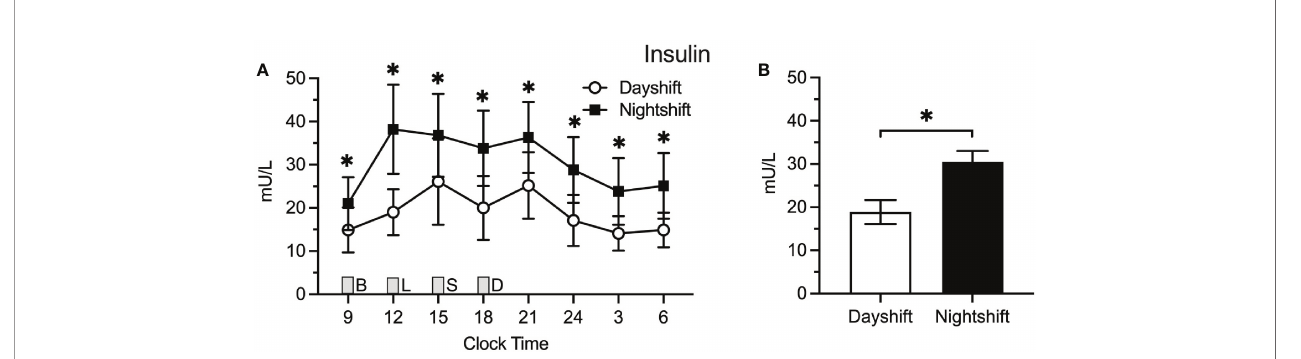
FIGURE 3 | Leptin Levels in Dayshift ( n = 8) Versus Nightshift Nurses ( n = 10). (A) Raw values ± SEMs for leptin as a function of clock time and shift type. (B) Mean 24-h values ± SEM for leptin by shift type, as derived from generalized additive models. Meals were served at 09:00 (B, breakfast), 12:00 (L, lunch), 15:00 (S, snack), and 18:00 (D, dinner) and are designated with a grey box. *p < 0.05.